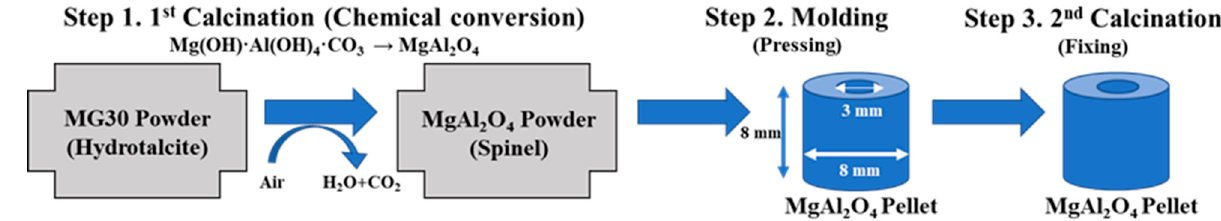
Figure 11. Schematic diagram of the pellet making procedure.